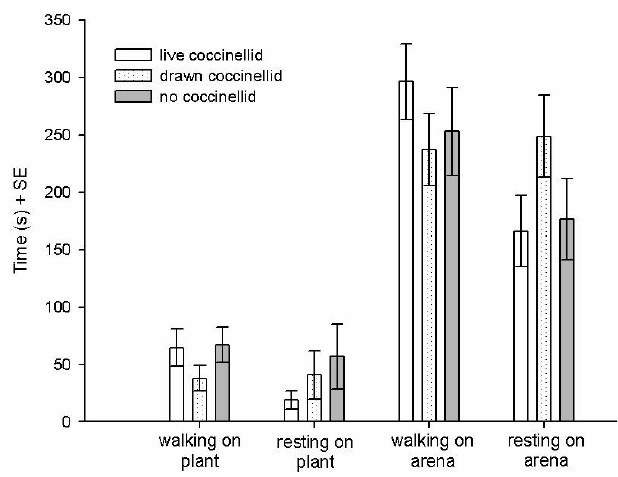
Fig 2. Time spent walking and resting by Camponotus ants on the stem/leaves and arena (cup) of three treatments: live coccinellid (scent and visual cues), drawn coccinellid (visual cue only), and no coccinellid (no predator cue).